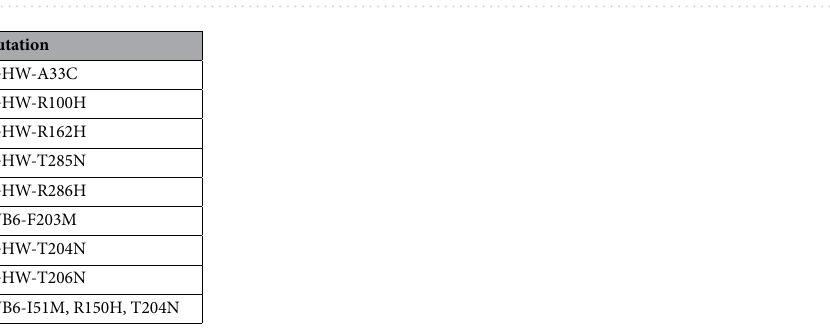
Figure 4. ( a ) The snapshot of MD simulation of mutated proteins. Each protein is solvated in a box of water and simulated to collect the statistical data on the stability of mutants and co-mutants. ( b ) Mean Root Mean Square Deviation (RMSD) versus Mean contact distances for each candidate averaged over the whole trajectory.